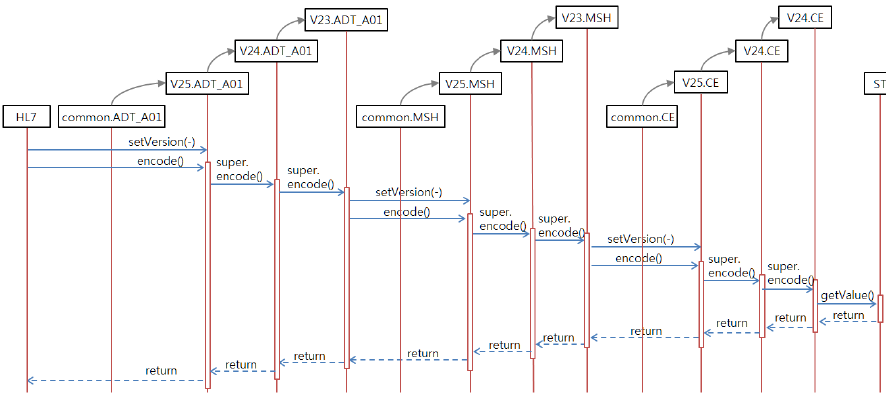
Fig. 8. Method diagram for encoding of an HL7 message for backward